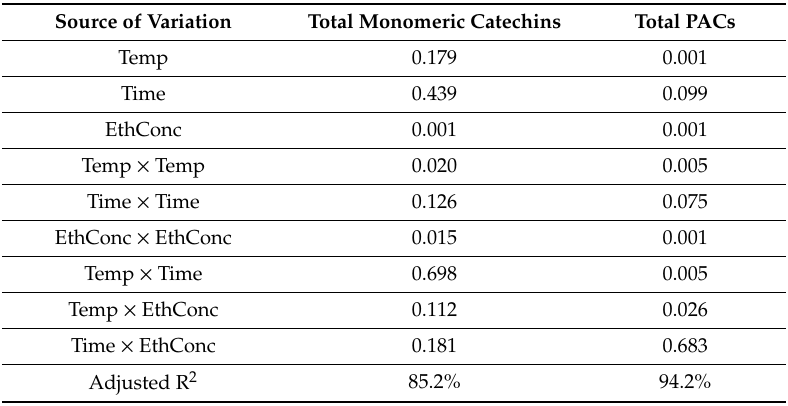
Table 2. Analysis of variance (ANOVA) p -values for the second-order response surface model for total monomeric catechins and total PAC